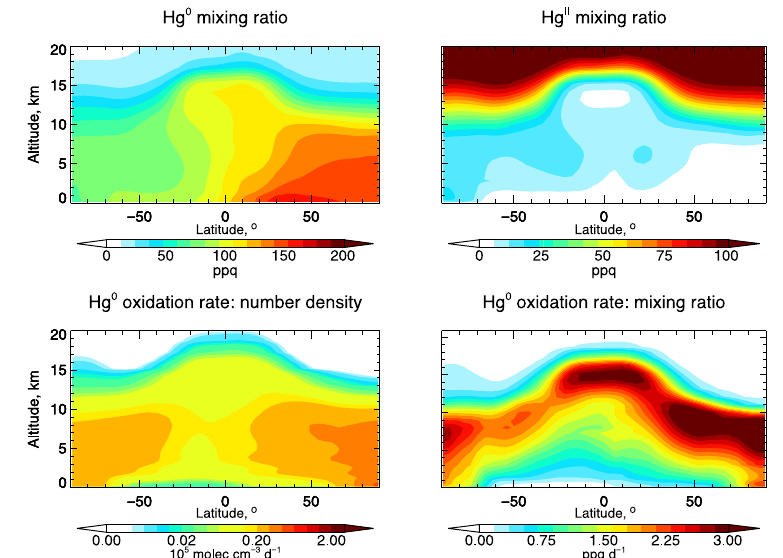
Figure 1. Annual (2009–2011) zonal mean mixing ratios of Hg 0 and Hg II in GEOS-Chem, and Hg 0 oxidation rates in number density and mixing ratio